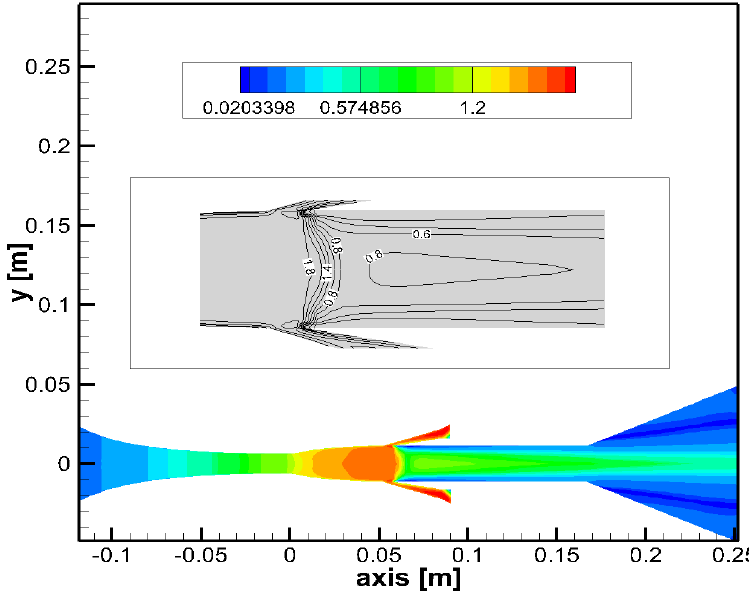
Figure 18. Internal Mach number distribution along the axial cross-section of the supersonic sepa- rator.